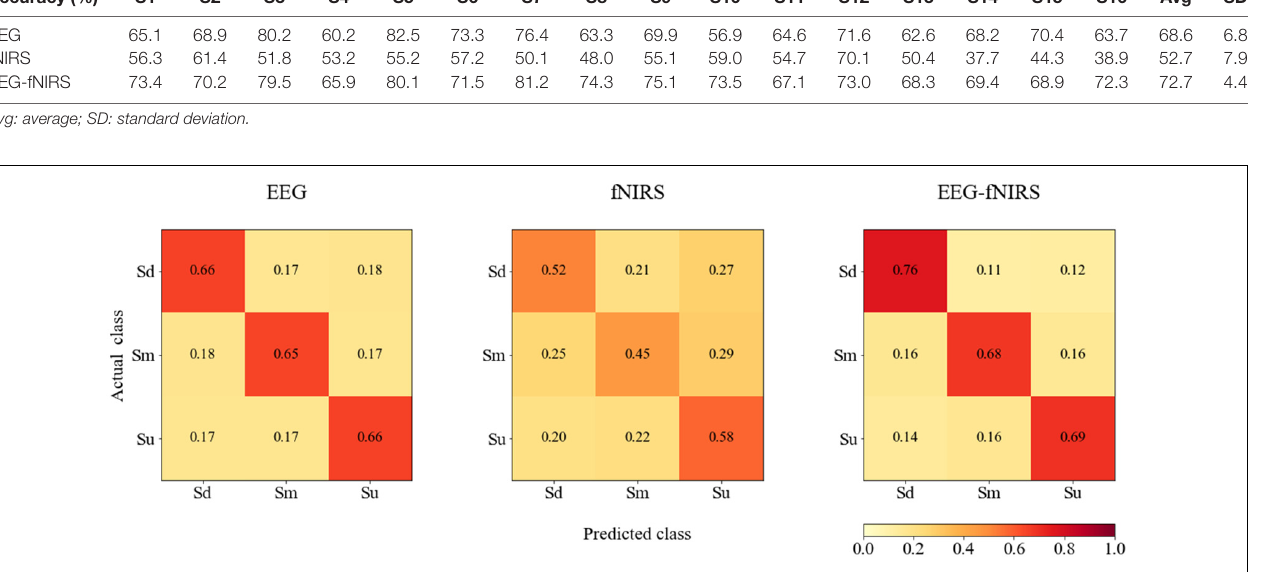
indicated that three types of complex brain networks exist, each corresponding to the observation of different action intentions. Because different action intention observations